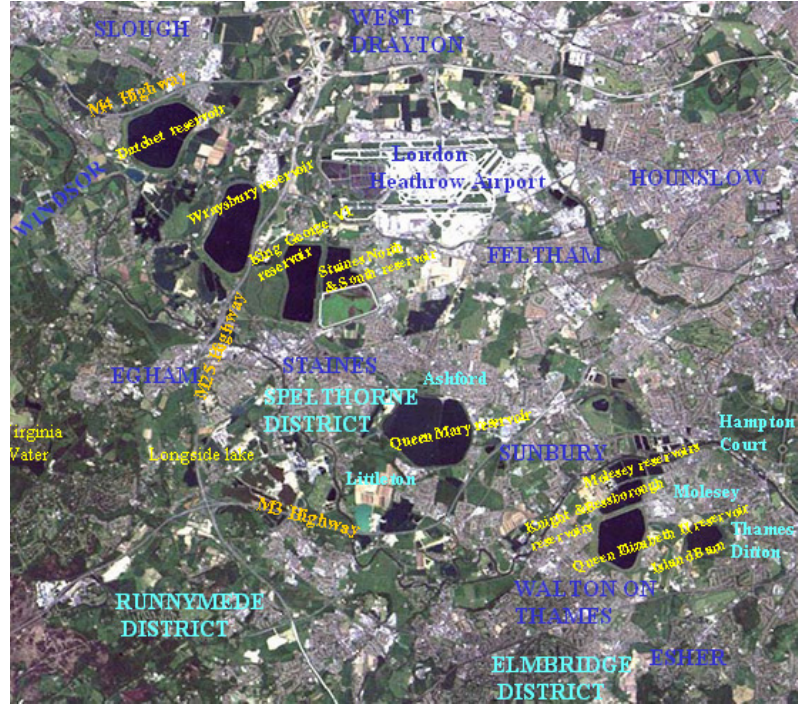
Figure 1. Partial scene of the Heathrow area and Lower Thames Valley reservoirs (Landsat-5 TM image acquired on 2 June 1985 displayed in true color combination with key locations and feature